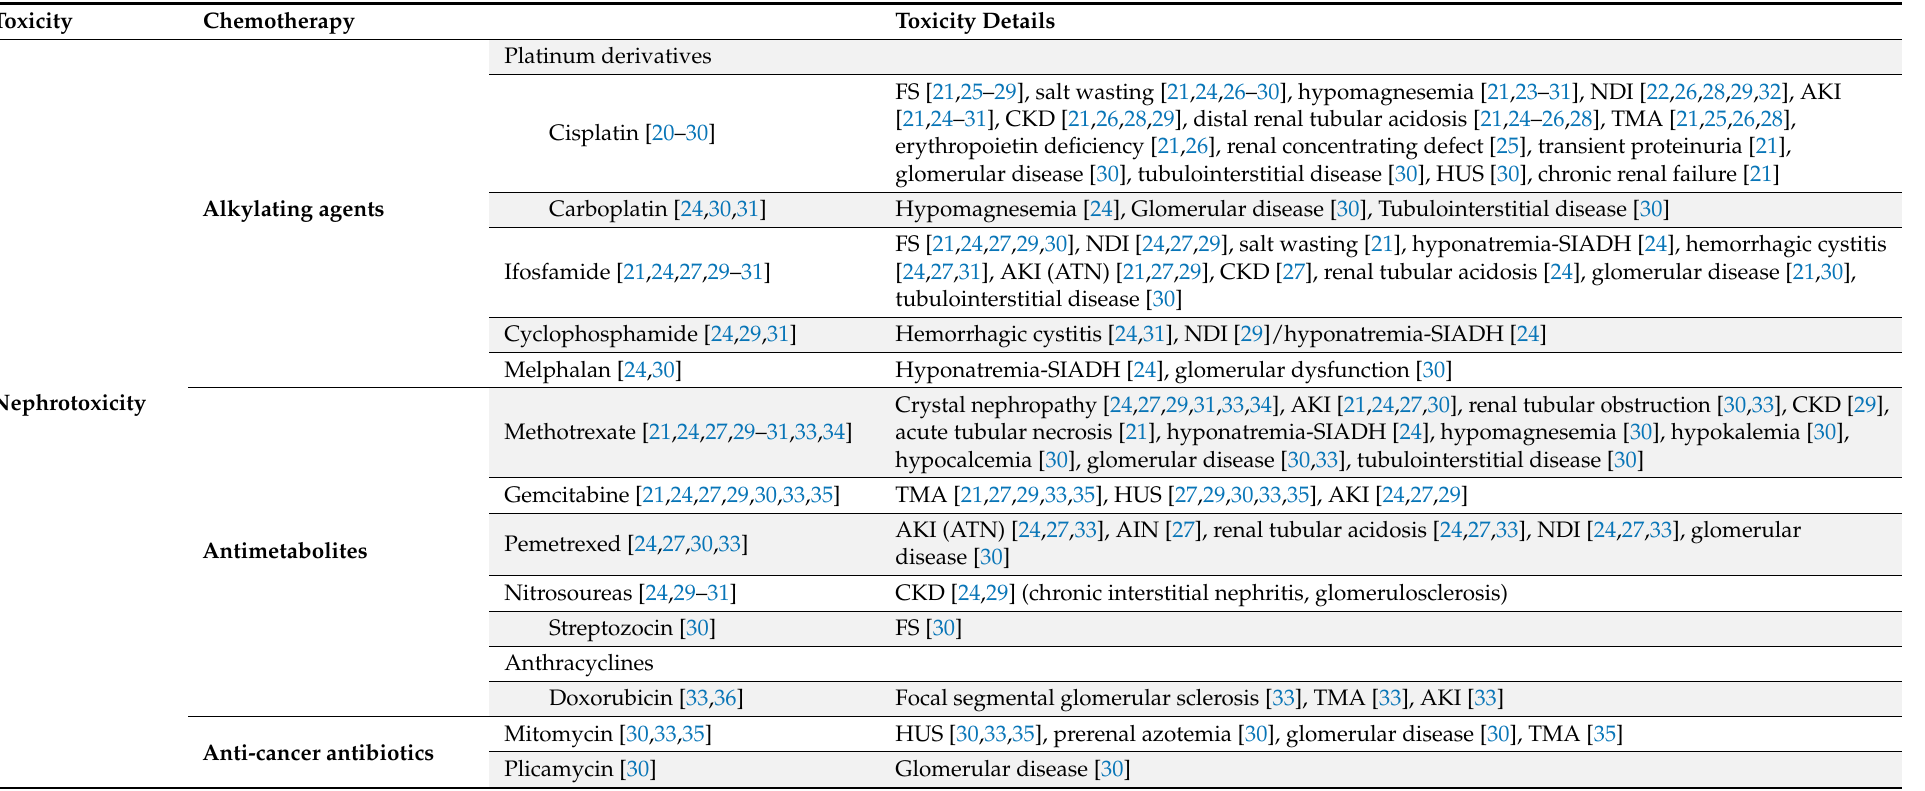
Table 1. Side-effects of anti-cancer therapy observed directly or late in